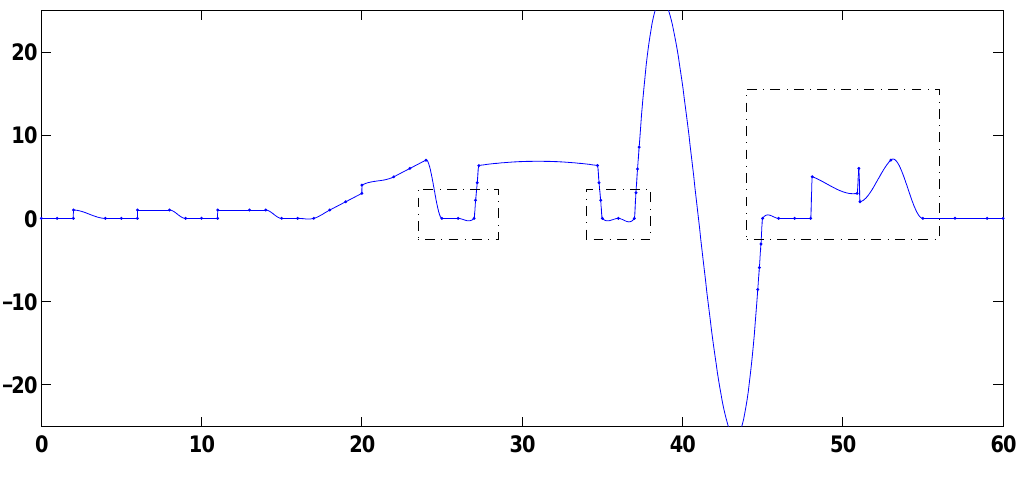
Figure 13 . Antiderivative-based global L